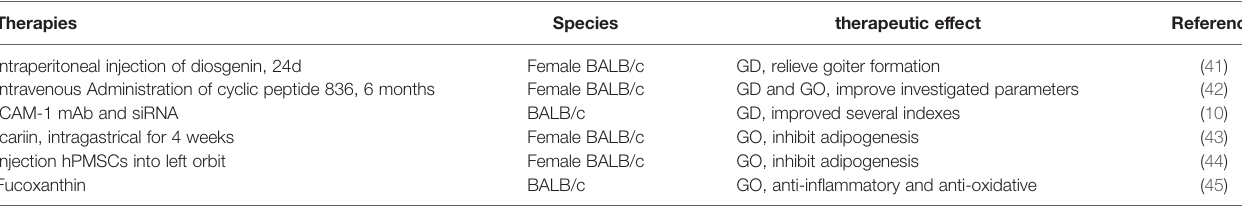
TABLE 2 | Overview on novel experimental therapies of Graves ’ disease and Graves ’ orbitopathy.